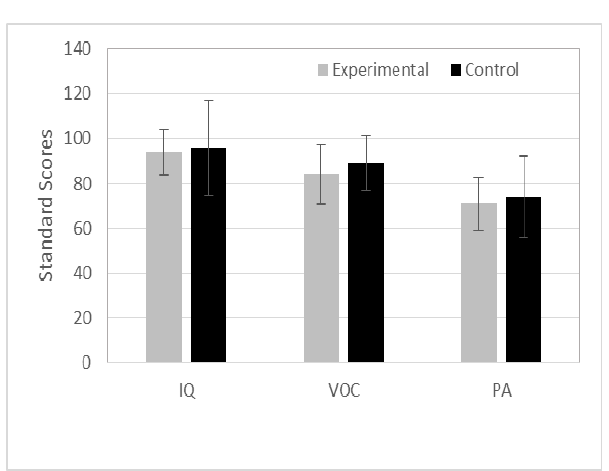
Figure 1. Means and standard deviations of nonverbal IQ, vocabulary (VOC), and phonological awareness skills (PA) between telepractice (experimental) and in-person (control)